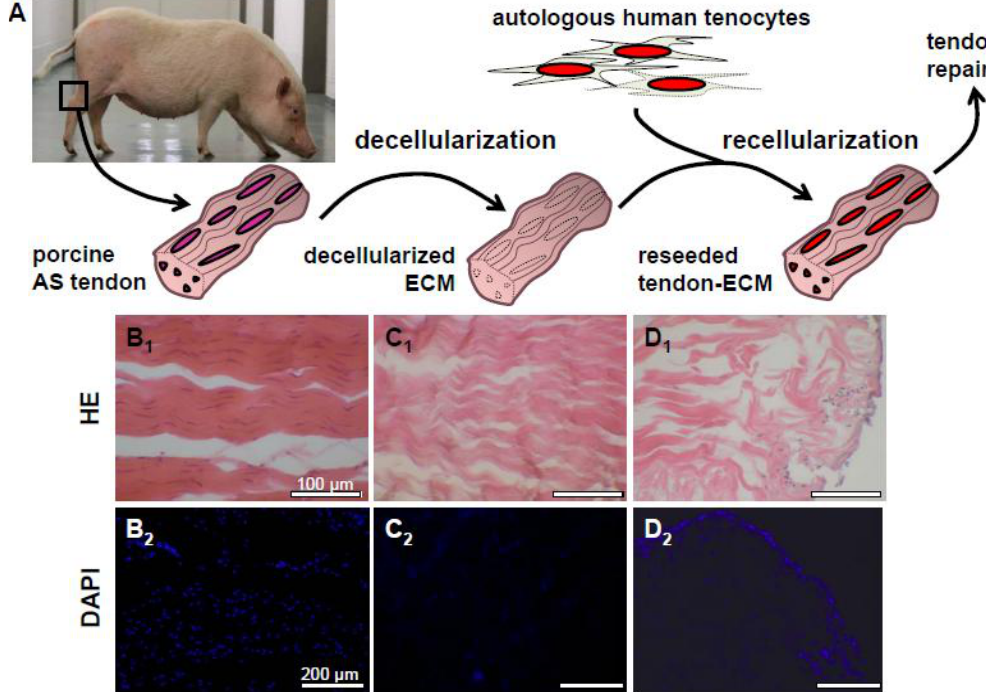
Figure 3. Dezellularization and recellularization of porcine Achilles tendons for tendon repair. Schematic diagram of the decellularization of porcine Achilles (AS) tendon as a scaffold for reseeding with autologous human hamstring tenocytes to use the resulting constructs for tendon defect coverage ( A ). HE and 4',6-diamidino-2-phenylindole (DAPI) , B ), decellularized ( C , C ) and a porcine Achilles (AS) tendon staining of a native ( B 1 2 1 2 , D ). Clefts arise between collagen ECM recolonized with human hamstring tenocytes ( D 1 2 , C , D ), (cid:21)(cid:19)(cid:19)(cid:3)(cid:541)(cid:80)(cid:3) fiber bundles in response to decellularization. Scale bars: 100 µm ( B 1 1 1 , C , D ) ( B 2 2 2